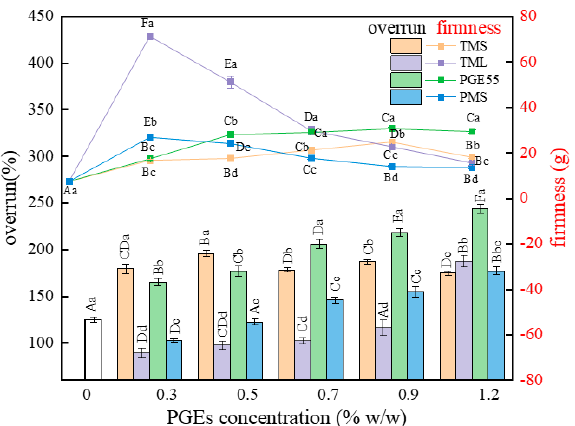
Figure 5. Effect of different PGEs on the overrun (the bar) and firmness (the line) of RDC. Uppercase letters indicate differences between concentrations, and lowercase letters indicate differences between PGEs.